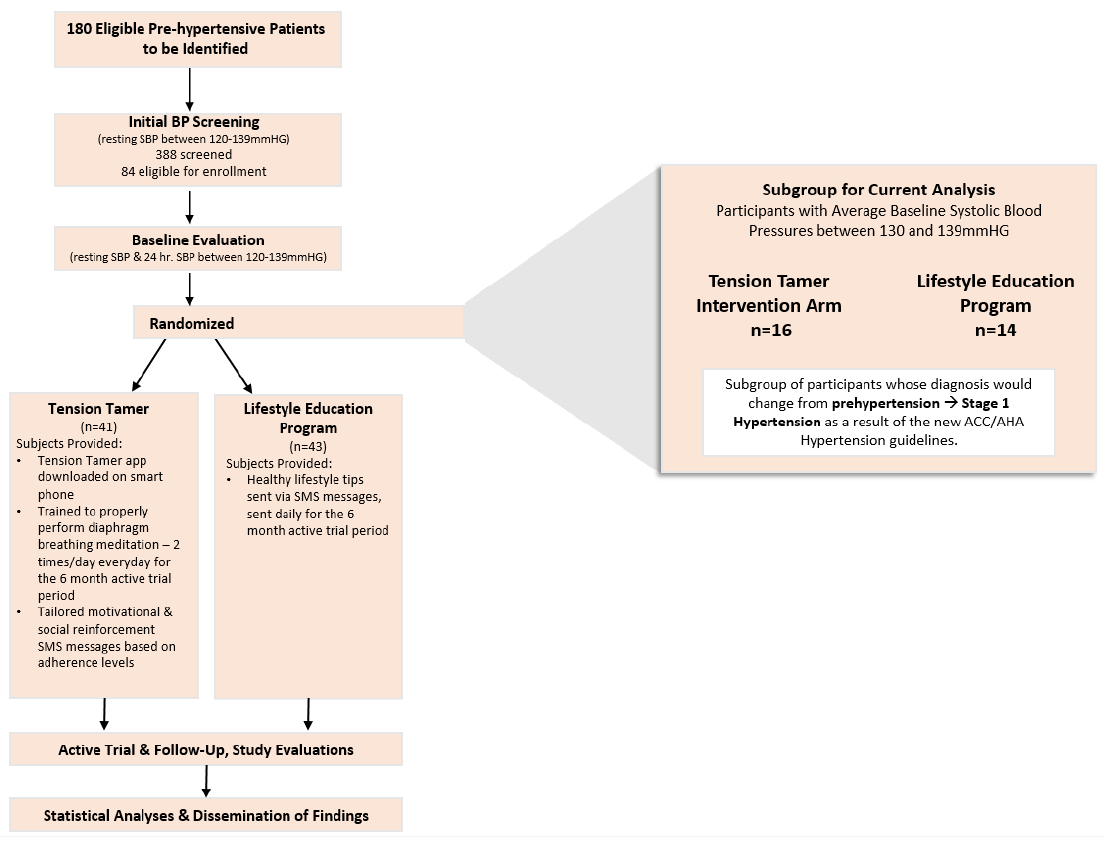
Figure 1. Consort diagram for tension tamer RCT.